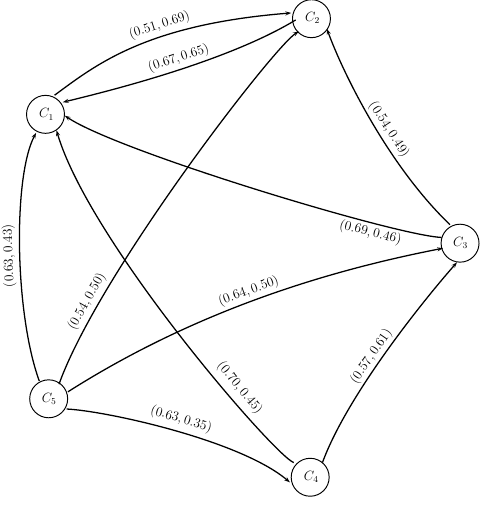
Figure 19. Partial directed network of the fused